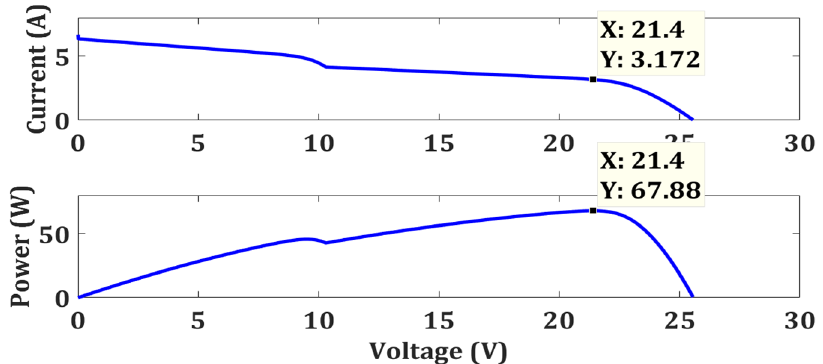
Figure 39. Characteristic curve of 2S2P PV system for test case 3.